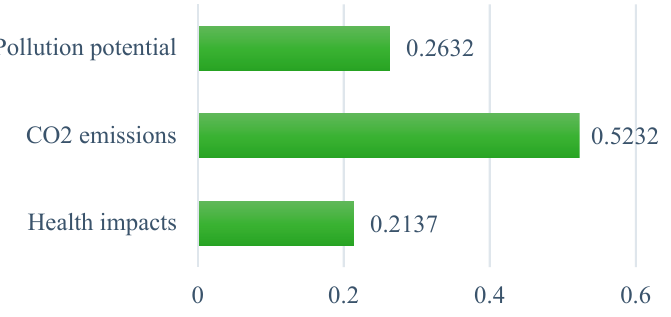
Figure 9. Priority weights of the environmental sub-criteria.